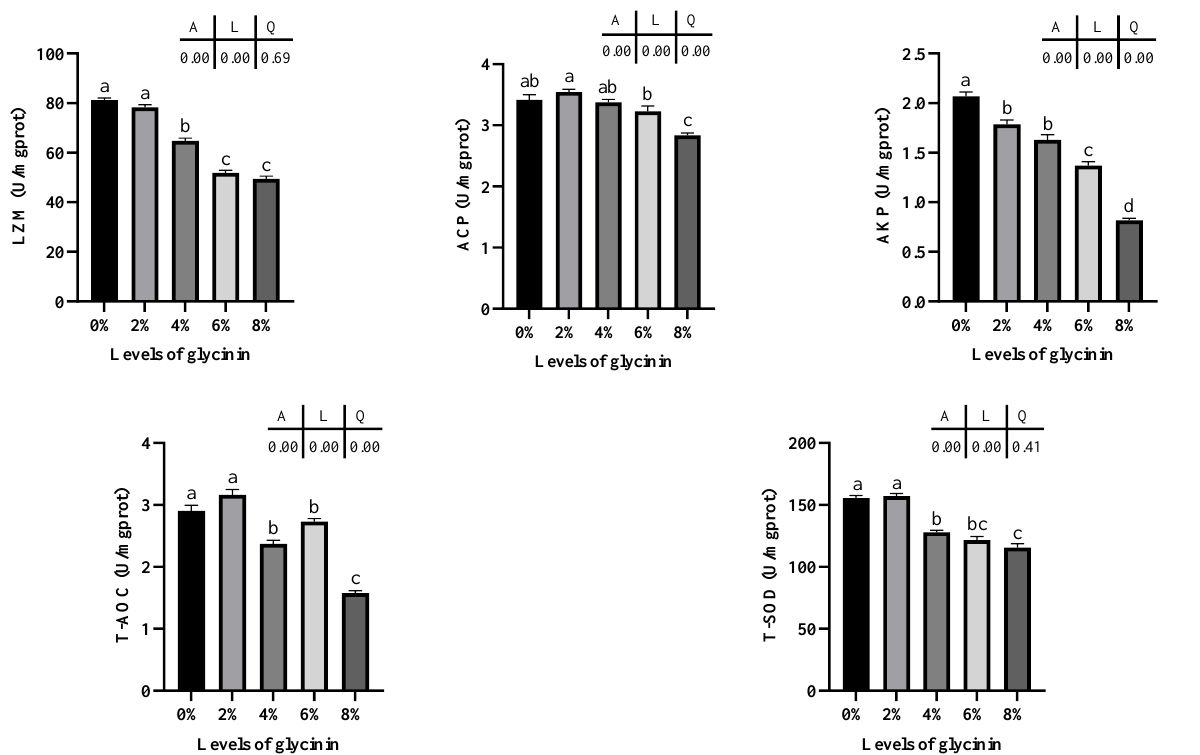
Figure 4. The antioxidant and nonspecific immune enzyme activity in posterior intestine of hybrid yellow catfish fed with different glycinin levels. Data describe mean ± SE (n = 3). Obvious difference of means between groups is indicated by a, b, c and d ( p < 0.05). A represent the variance analyzed by one-way ANOVA; L represent linear trend analyzed by orthogonal polynomial contrasts; Q represent quadratic trend analyzed by orthogonal polynomial contrasts.